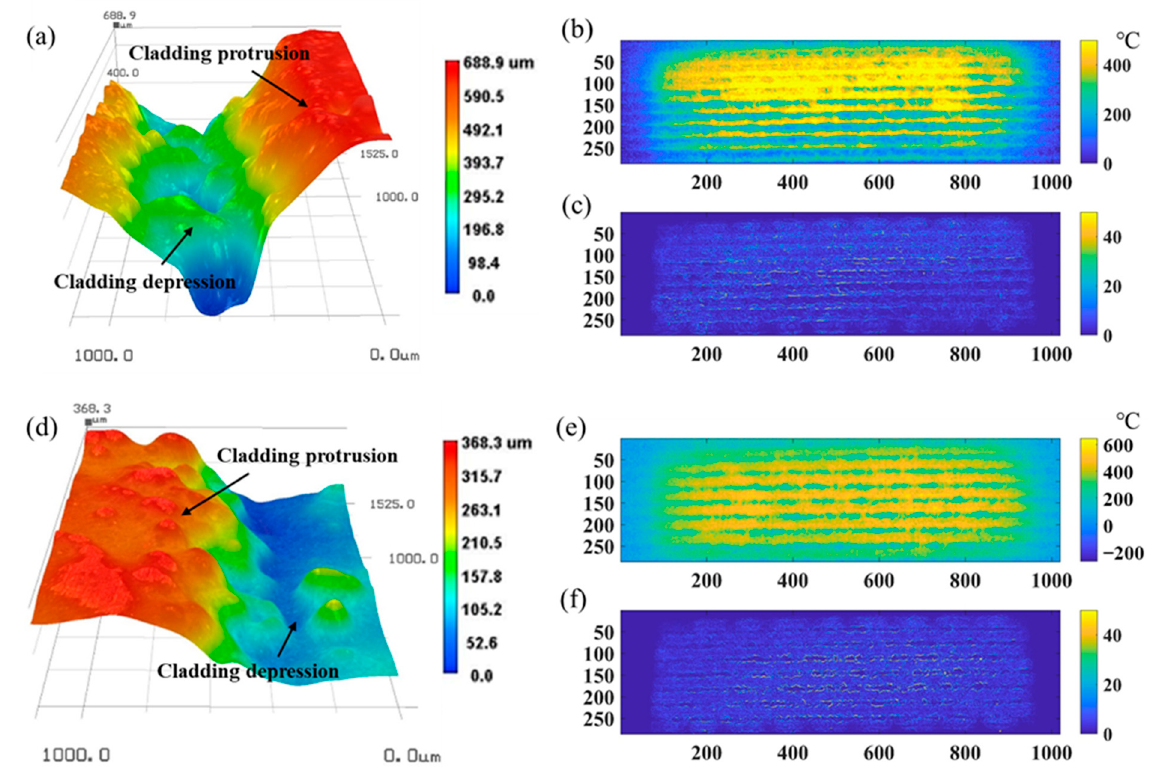
Figure 20. Thermographic detection of different surface structures: ( a ) local 3D morphology of repair area 2; ( b ) combined form of temperature change field after mask treatment in repair area 2; ( c ) Prewitt edge detection results for temperature change field in the repair area 2; ( d ) local 3D morphology of repair area 3; ( e ) combined form of temperature change field after mask treatment in repair area 3; ( f ) Prewitt edge detection for temperature change field in the repair area 3.